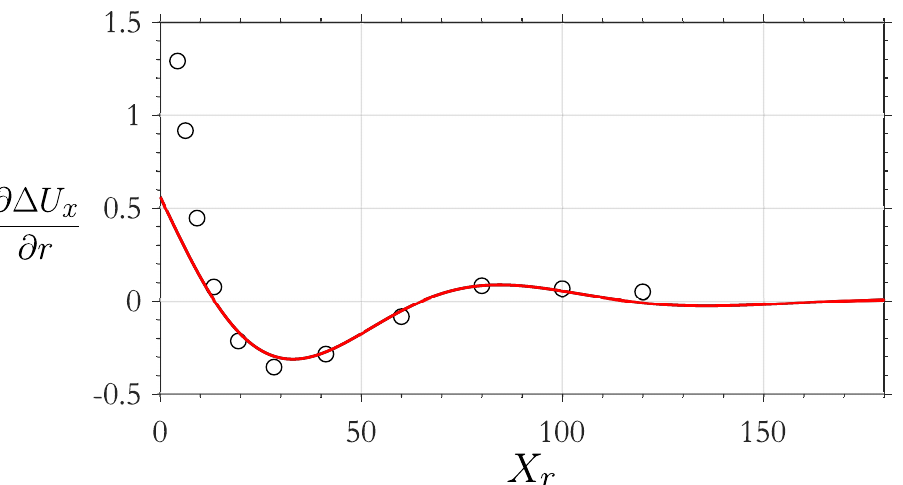
Figure 13. Comparison of the non-equilibrium turbulence model to turbulent pipe flow subject to a change in surface roughness. X r = x / R is the normalized stream-wise distance downstream of the rough-to-smooth step. (Reproduced with permission from [37], published by Cambridge University Press